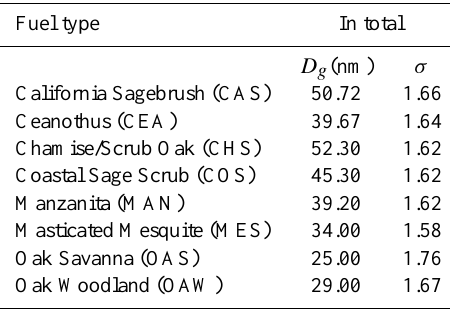
Table 3. Geometric mean diameter and the geometric standard de- viations.